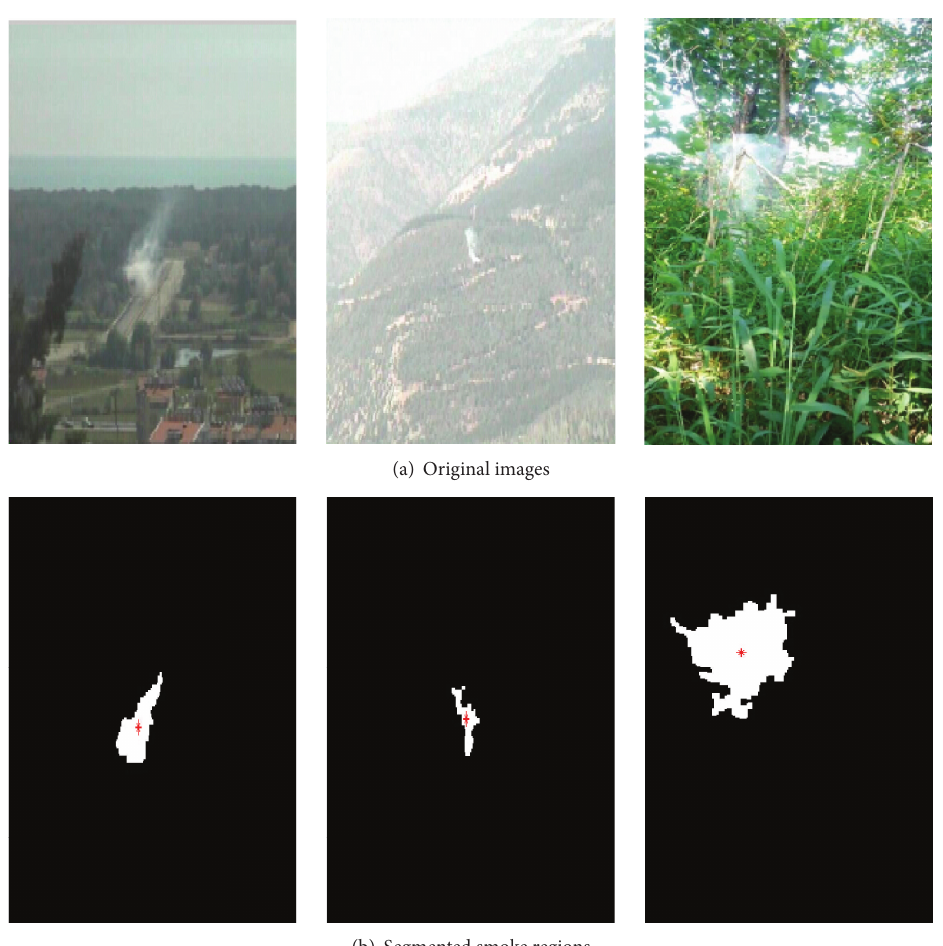
Figure 3: The results of smoke region segmentation.